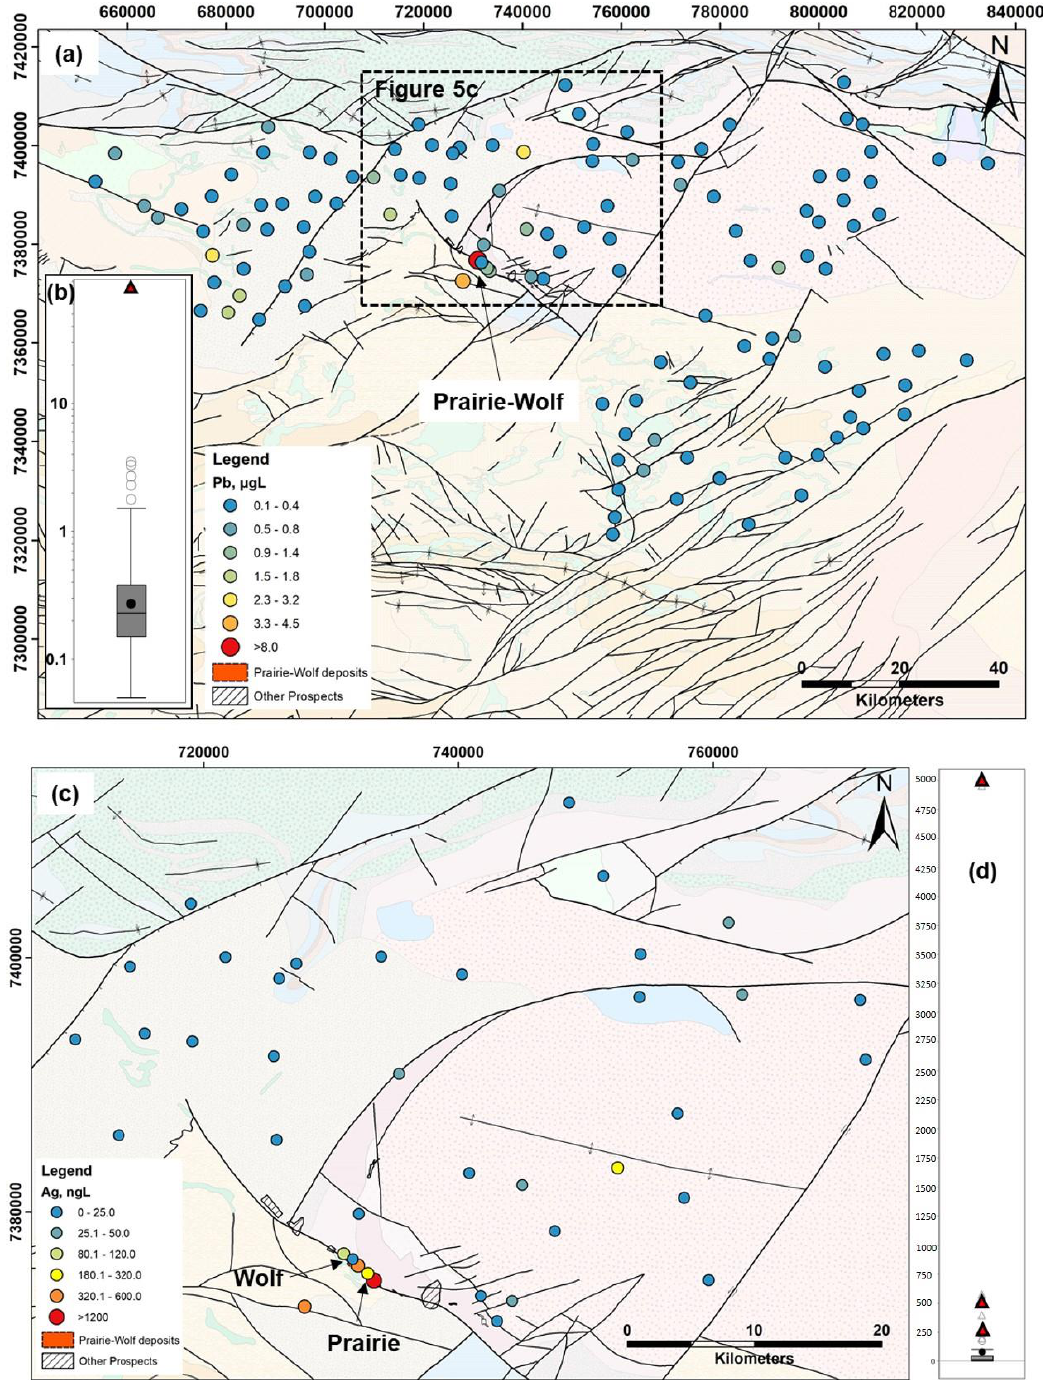
Figure 5. Groundwater samples within the study area. ( a ) Lead concentrations in groundwater samples. ( b ) Logarithmic scale box plot (ioGAS version 7.2) of Pb in regional groundwater samples (n = 132). Triangles in box plots indicate far outliers. Outlier indicated in red represents the extremely high Pb concentrations in a sample along the Prairie Downs fault zone (arrow in ( a )). Data below detection limit were replaced with half the detection limit. ( c ) Silver concentrations over the study area, indicating elevated values along the Prairie-Downs fault line. ( d ) Box plot (ioGAS version 7.2) of Ag (in ppt) in regional groundwater samples (n = 132). Triangles in box plots indicate far outliers. Outliers indicated in red represent the high Ag concentrations in three samples along the Prairie-Downs fault line (arrow in ( a )). Please refer to the Supplementary Data for a lithological legend.